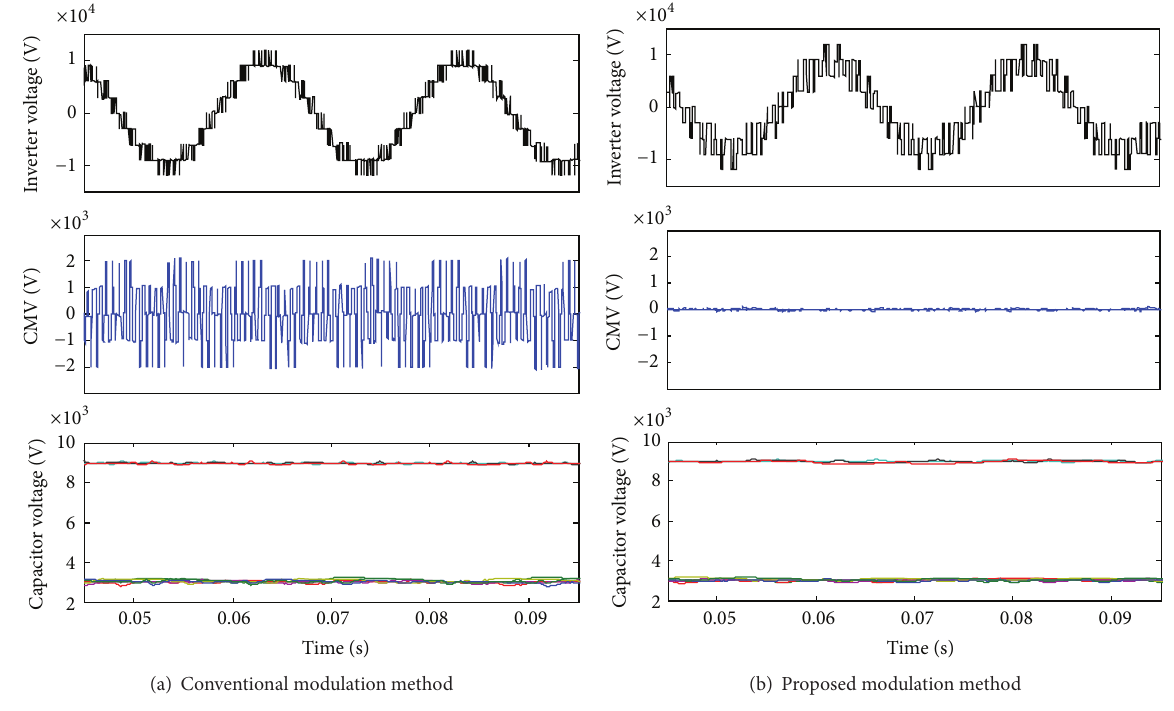
(a) Conventional modulation method Figure 6: Simulation results of different modulations.